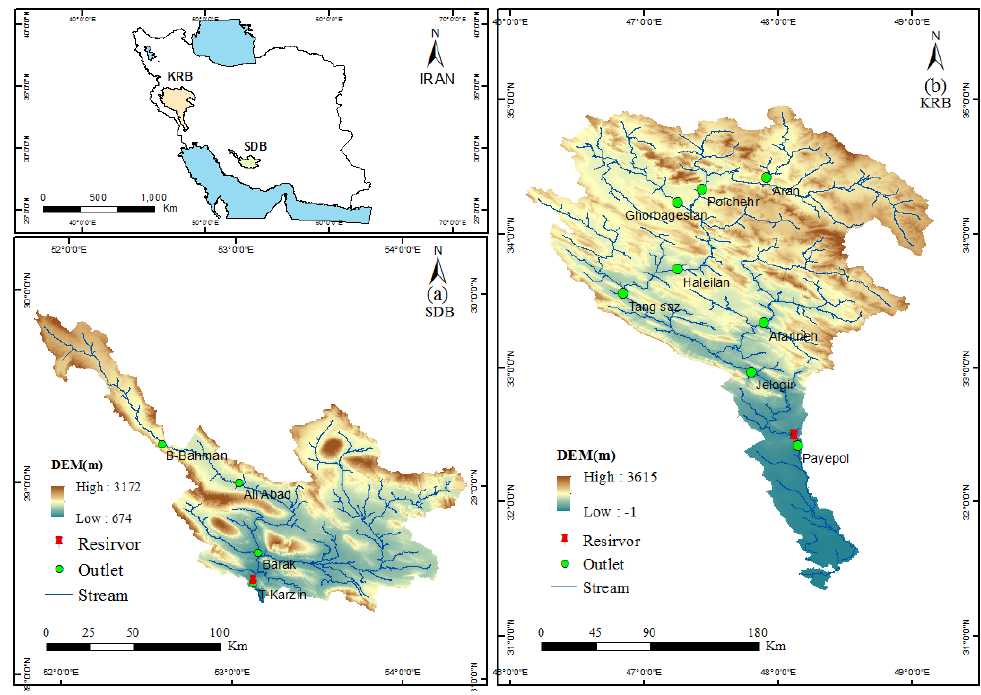
Figure 1. Location of the study areas: ( a ) Salman Dam Basin (SDB) and ( b ) Karkheh River Basin